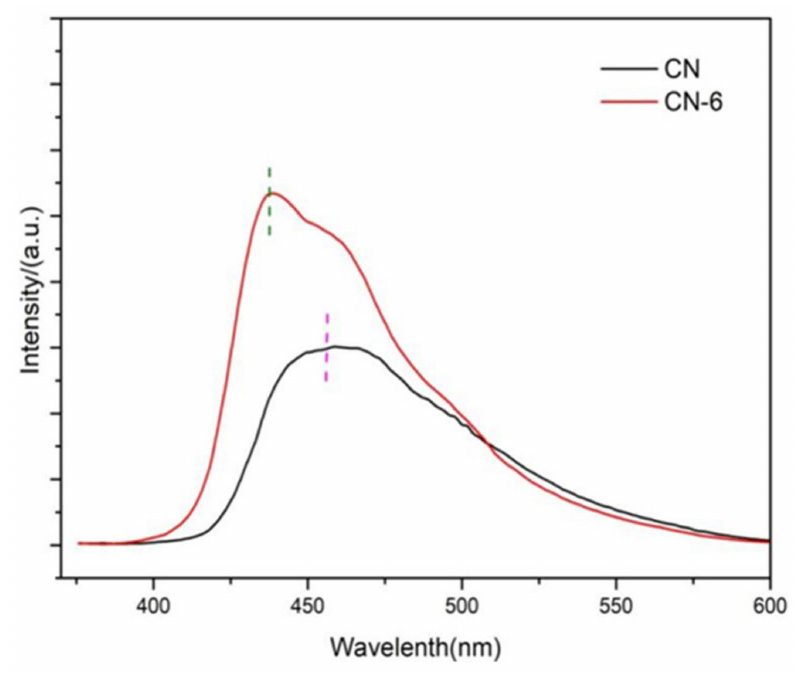
Figure 8. PL spectra of CN and